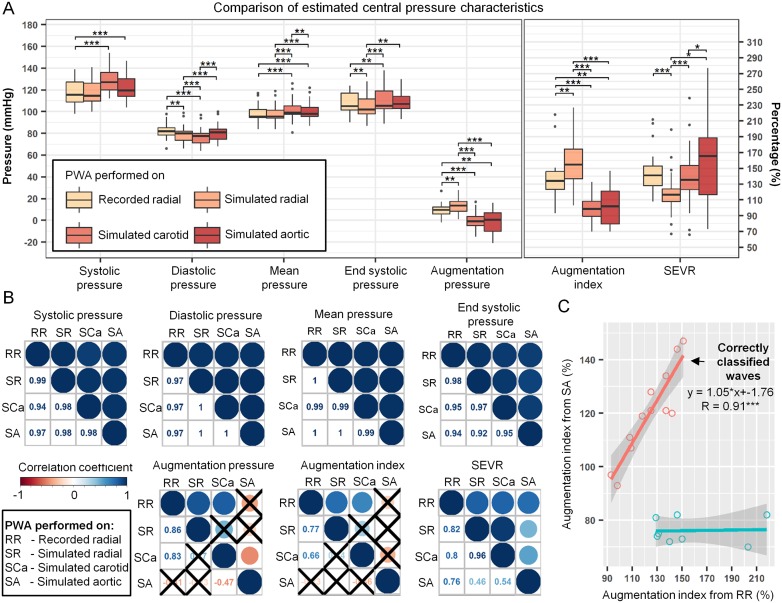
Comparison of the central pulse wave characteristics estimated using SphygmoCor software using different input pressure waveforms, i.e. recorded radial (RR), simulated radial (SR), simulated carotid (SCa), and simulated aortic (SA) waveforms.(A) Boxplots comparing pressure indices together with augmentation index and sub-endocardial viability ratio (SEVR). Symbols *, **, and *** denote p-value < 0.05, < 0.01 and < 0.001, respectively. (B) Pearson correlation coefficient matrices between different central waveform characteristics. Shown is a graphical representation of the correlation coefficient where size and color of the circle indicates correlation strength and direction (upper diagonal) together with correlation coefficients values (lower diagonal). Correlation coefficients with p-value ≥ 0.05 are crossed out. (C) Scatter plot and linear regression models comparing augmentation index estimated using recorded radial and simulated aortic pressure waveforms. Shown is also regression equation and Pearson correlation coefficient for the subgroup of patients for which both aortic waves were classified as the same type.